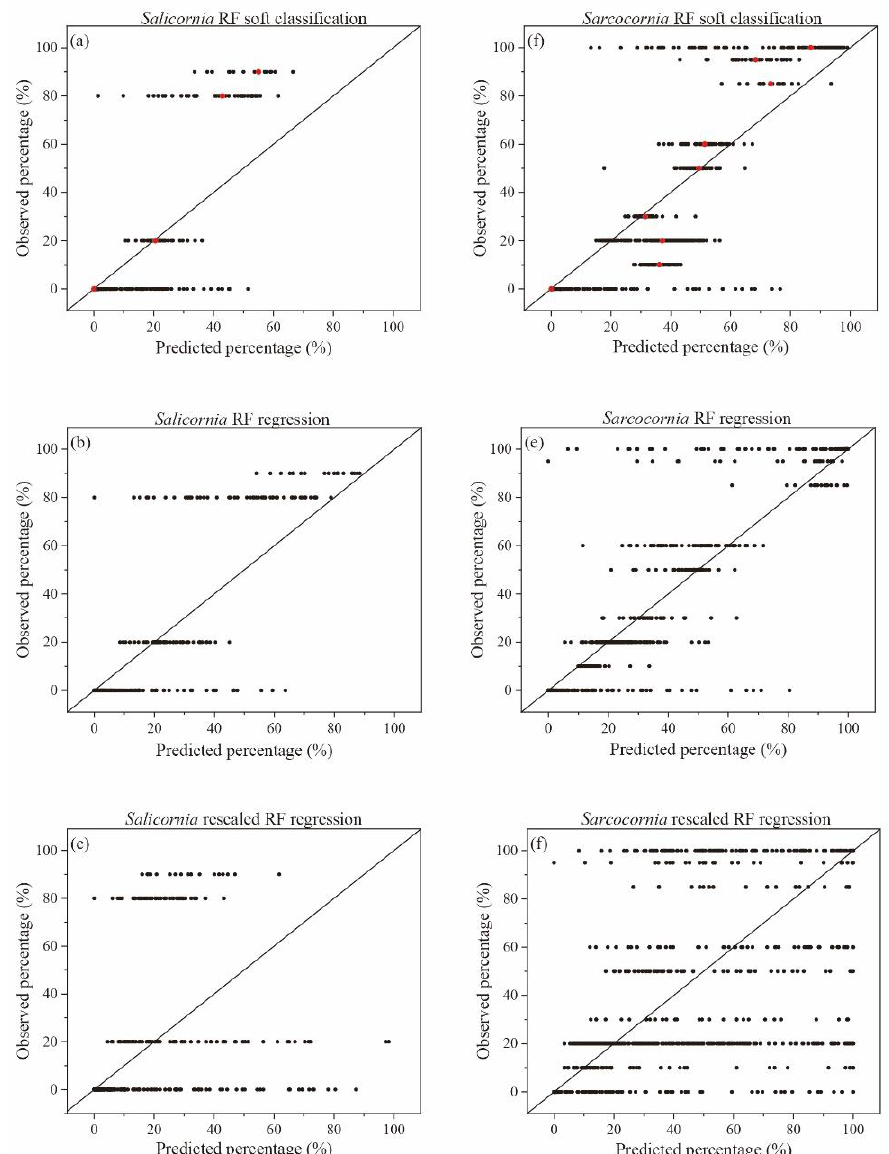
Figure 8. Validation results for Salicornia and Sarcocornia : ( a , d ) are predicted probabilities (x-axis) plotted against the validation data; ( b , e ) are regression results (x-axis) plotted against the validation data; ( c , f ) are rescaled regression results (x-axis) plotted against the validation data. Red dots represent the mean of the predicted percentage using the RF soft classification.